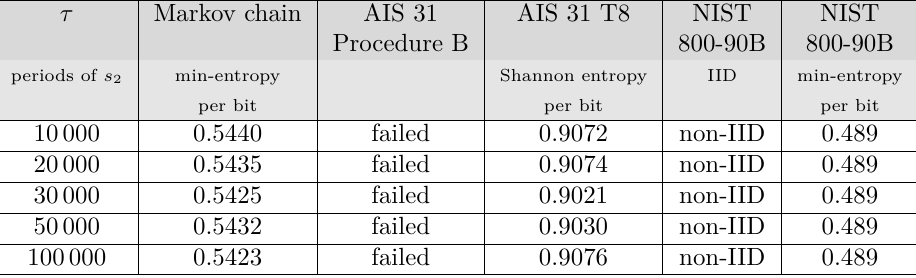
Table 6: Entropy estimation using high order Markov chains, AIS 31 and NIST 800-90B tests, when two internal STRs and the sampling method was used. Dependencies are modeled using 8 th order Markov chains.